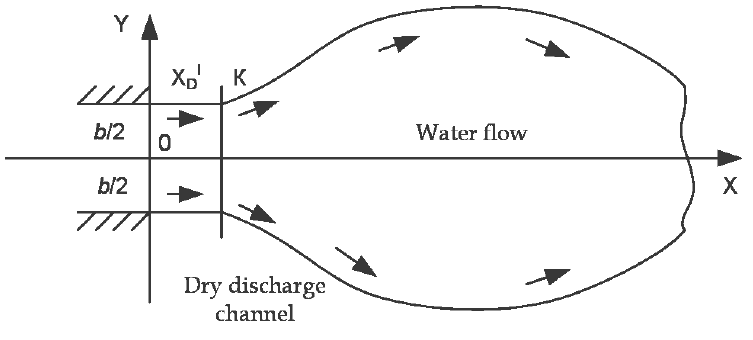
Figure 1. Schematic of a real flow